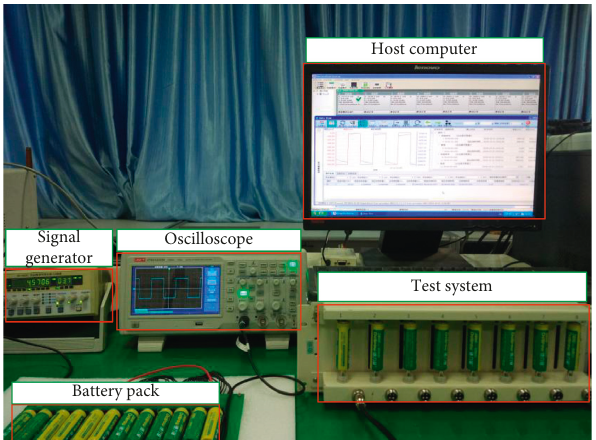
Figure 9: Experiment platform of the equalization circuit.